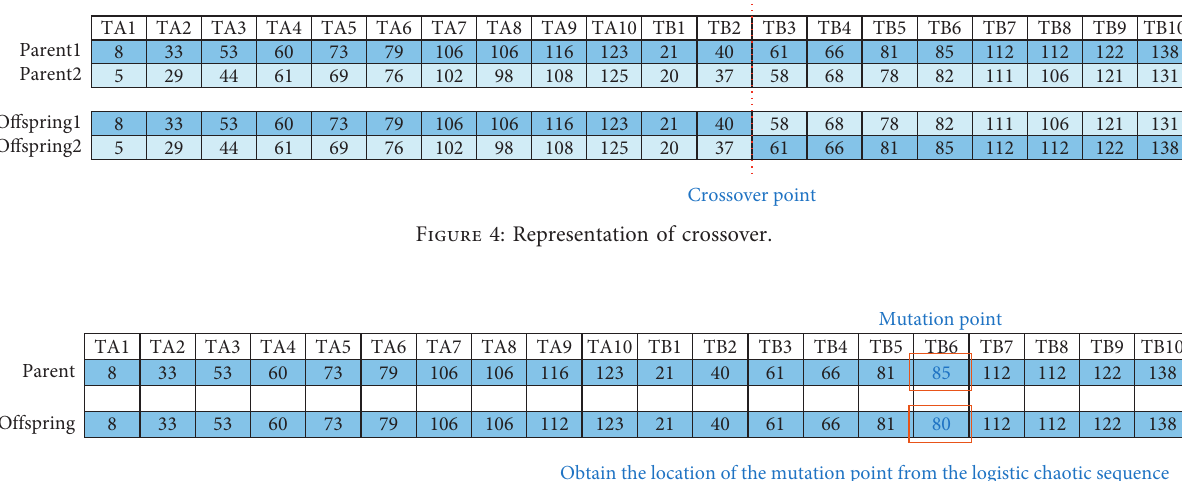
Figure 5: Representation of mutation.